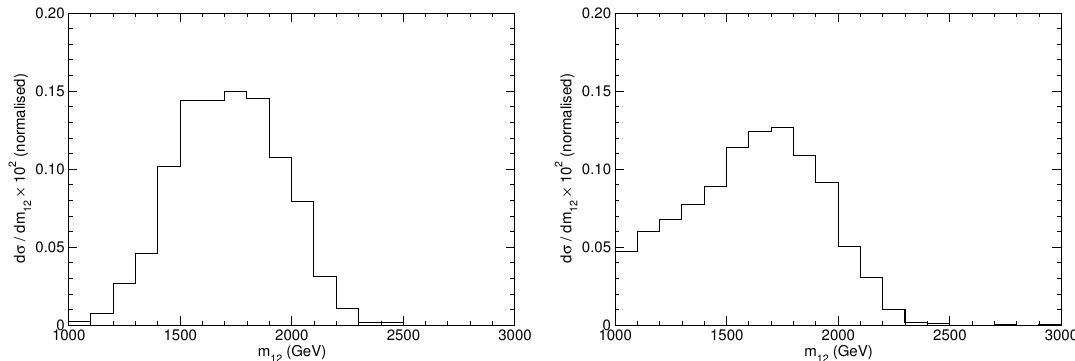
Figure 4 . Sample distributions for triboson signals after event selection (see the text), normalised to unity. Left: symmetric bump. Right: asymmetric